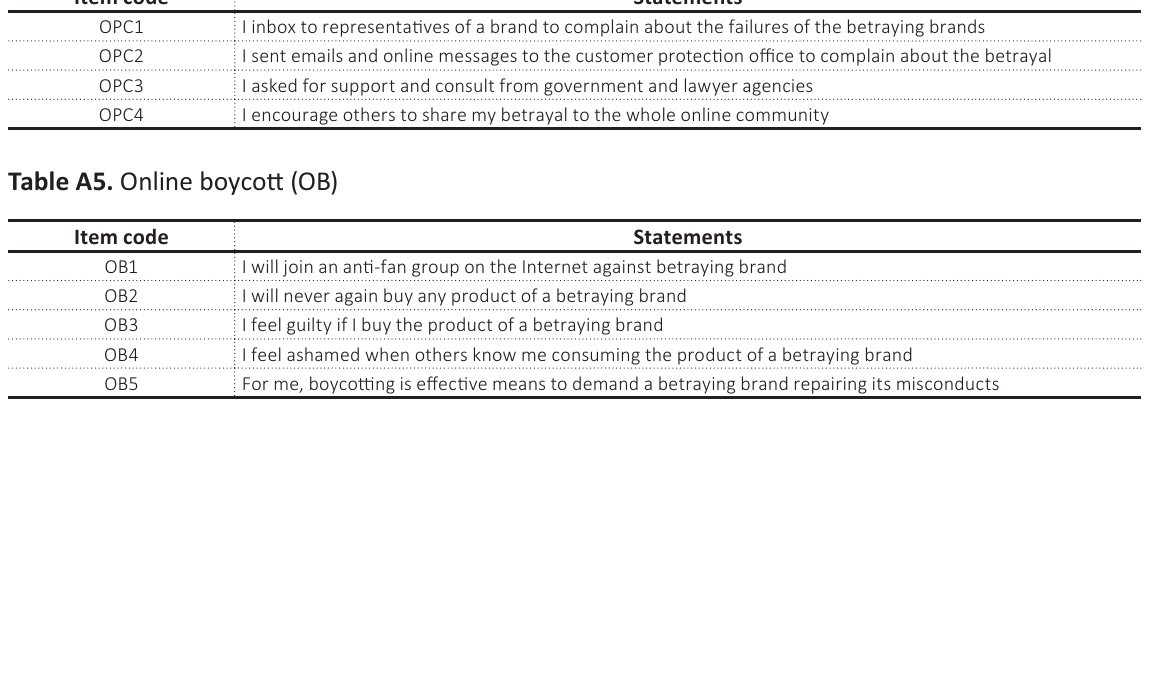
Table A4. Online public complaining (OPC) Item code